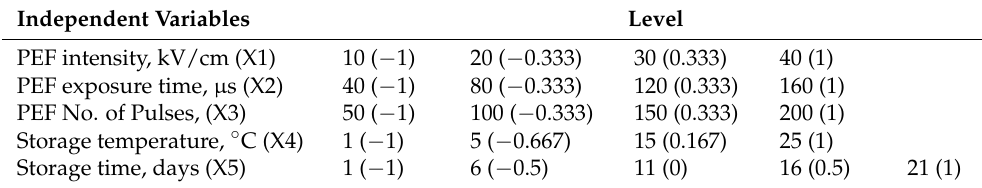
Table 1. Independent variables and their level used for central composite design. Independent Variables